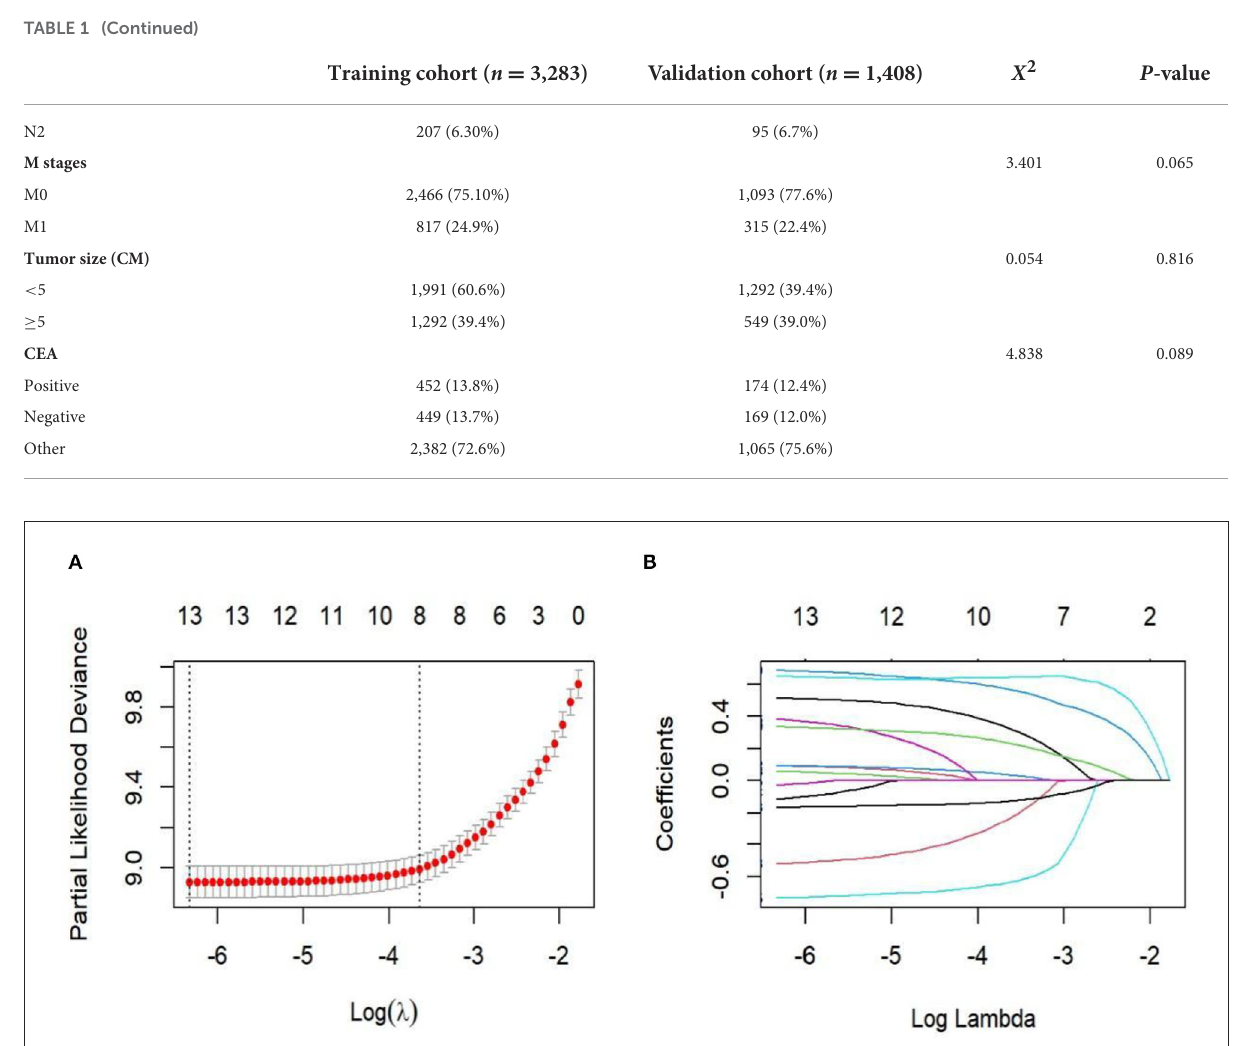
FIGURE1 Lasso regression for cross-validation and regression analysis. (A) Cross-validation; (B) Lasso regression path diagram.